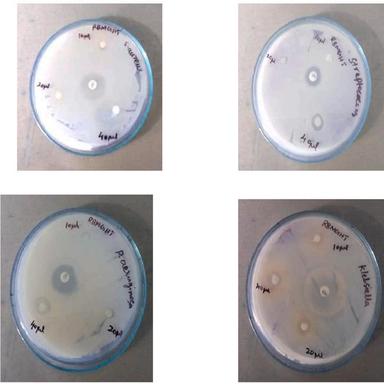
The inhibition area diameter of RbCl doped MgO nanoparticles.